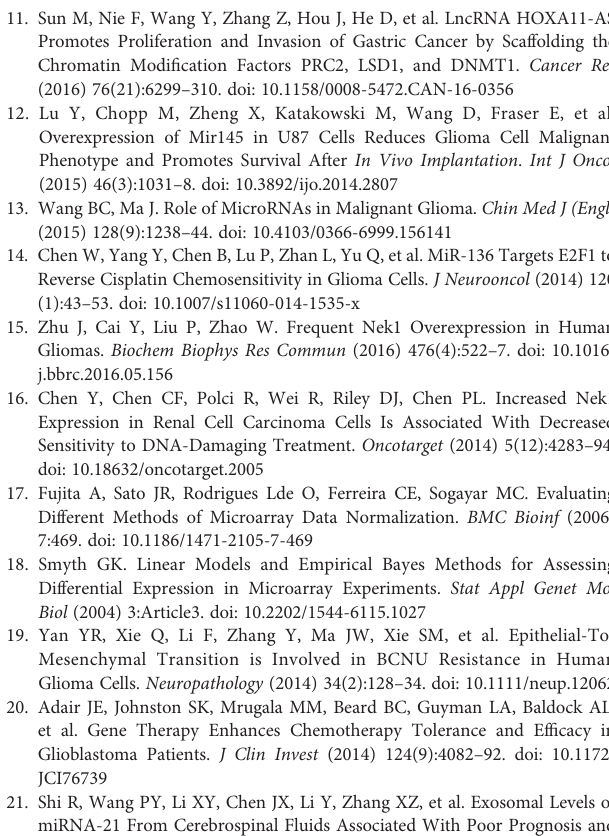
Supplementary Figure 1 | Bioinformatics analysis predicts the regulatory mechanism of LINC00883 in glioma. (A) The intersection results of the DEGs in gliomas in the GSE15824 and GSE4290 datasets and TCGAdatabase by the jvenn website. (B) A heat map of the top 10 DEGs in the GSE15824 dataset. The abscissa refers to sample number, and the ordinate refers to names of DEGs. The upper dendrogram refers to cluster analysis of sample types, and the color band represents the sample type. The left dendrogram refers to the cluster analysis of DEGs. Each block represents the expression of gene in one sample, and the upper right histogram refers to color gradation. (C) Expression of LINC00883 in glioma and normal samples in the GSE4290 dataset. (D) Expression of LINC00883 in glioma and normal samples in TCGA database. (E) Correlation of LINC00883 and NEK1 in glioma samples analyzed by the starBase website. (F) Expression of NEK1 in glioma and normal samples in TCGA database. Supplementary Figure 2 | Representativeimages and representative western blots. (A) Representativeimagesofcolonyformationassayafterectopicexpressionand depletion of LINC00883. (B) Representativeimages ofEdU assay of U251 cells after ectopic expression anddepletion of LINC00883 (× 200). (C) Representativewestern blots of Bax, NEK1, PCNA, MRP and Bcl-2 inU251 cellsinresponse to ectopic expressionanddepletionofLINC00883. (D) Representativeimagesofcolonyformation assayafterectopicexpressionanddepletionofmiR-136. (E) Representativeimagesof EdU assay of U251 cellsafter ectopic expression or depletion of miR-136 (×200). (F) RepresentativewesternblotsofBax,NEK1,PCNA,MRPandBcl-2inU251cellsin response to ectopic expression or depletion